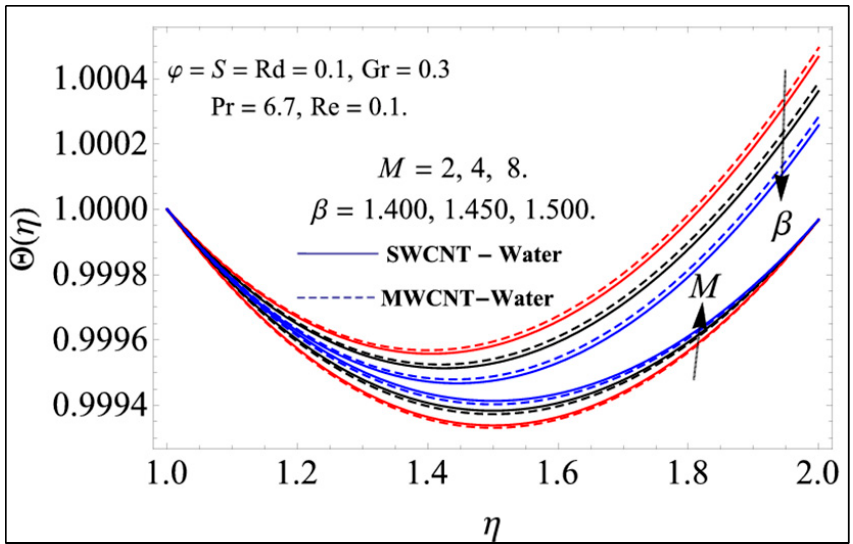
Figure 7. Impact of the M & β on the temperature field.